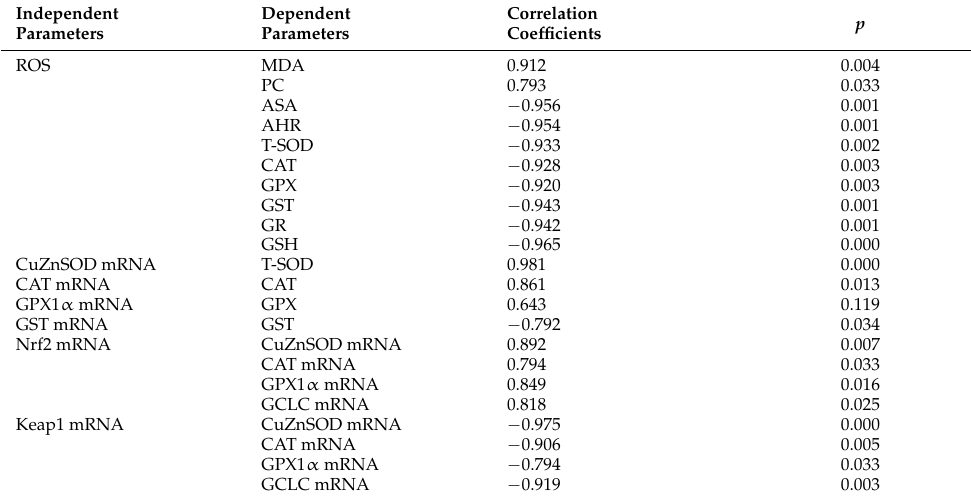
Table 3. Correlation analysis of parameters in the muscle of hybrid catfish. Independent